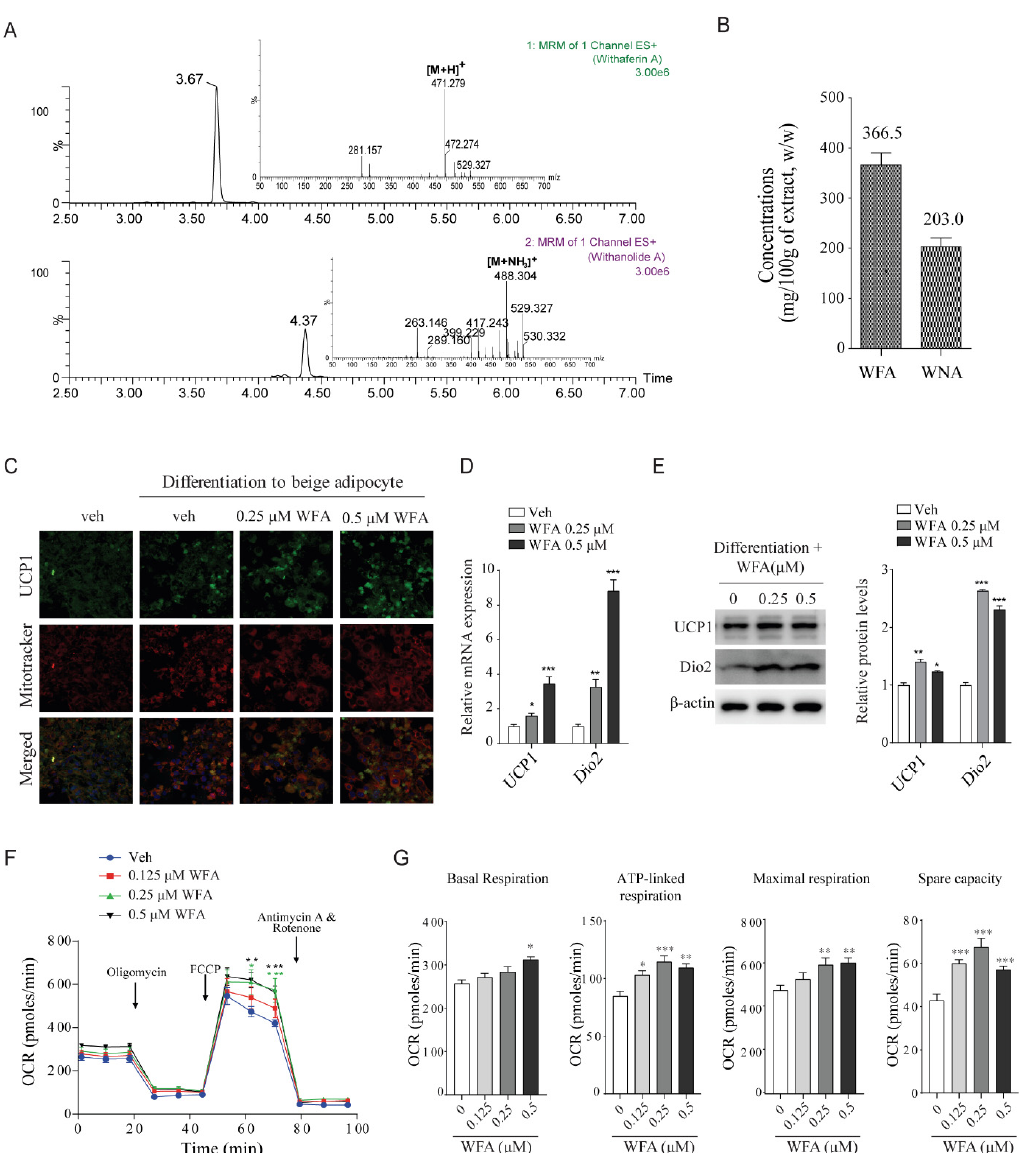
Figure 4. Withaferin A (WFA) in WS enhances the differentiation into beige adipocytes and increases OCR. ( A ) LC-MS/MS analysis of WSE. ( B ) Contents of WFA and withanolide A (WNA) in 100 g of WSE. ( C ) UCP1 expression in differentiated 3T3-L1 beige adipocytes. ( D ) Expression of brown adipocyte-specific mRNA in differentiated 3T3-L1 beige adipocytes. ( E ) WFA increases protein expressions of UCP1 and Dio2 in beige adipocytes ( n = 3). ( F ) WFA increases the OCR in C2C12 cells. C2C12 cells were treated with the indicated concentrations of WFA for 24 hours. ( G ) Quantification of basal respiration, ATP production, maximal respiration, and spare capacity. Data represent mean ± SD of three independent experiments. Difference between groups was evaluated by Tukey’s multiple comparison test. * p < 0.05; ** p < 0.01, *** p < 0.001 compared with the vehicle group.